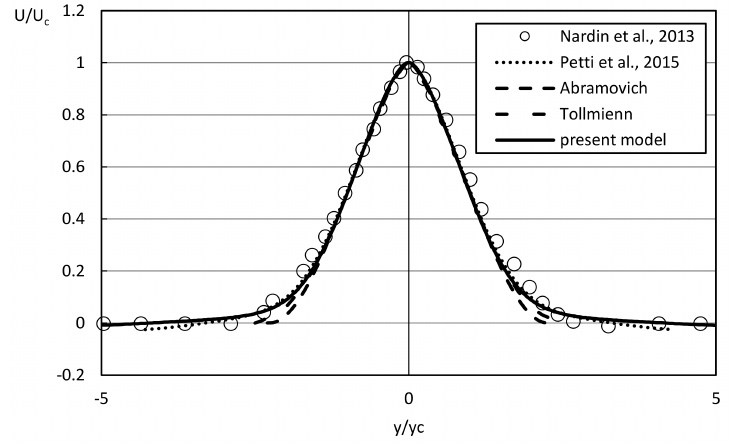
Figure 4. Longitudinal velocity U, taken along a transverse transect 780 m from the jet inlet, normalized with the centerline velocity, U c . In the abscissa, y is the distance from the jet axis and y c is the local half-width of the jet, corresponding to the location where the mean velocity is equal to half the centerline velocity U c